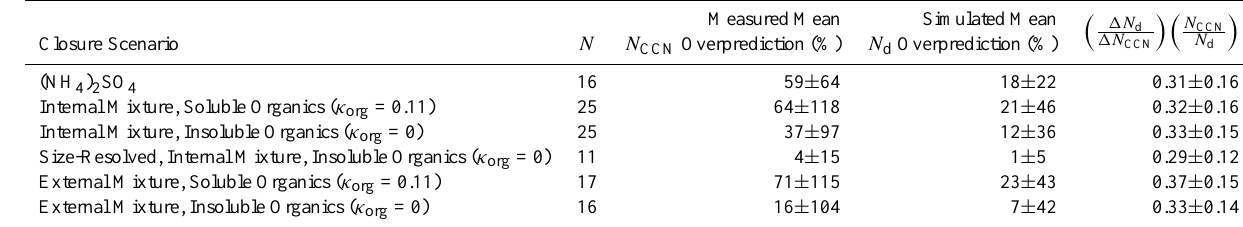
Table 5. Percent overprediction of CCN concentration domain of each field study, with equal weighting given to each study location regardless of area. Reported are the mean ± one standard deviation across the 36 different datasets. Since individual field studies do not apply all scenarios, the overprediction values cannot be directly compared; however, the domain-averaged sensitivity ratios in Table